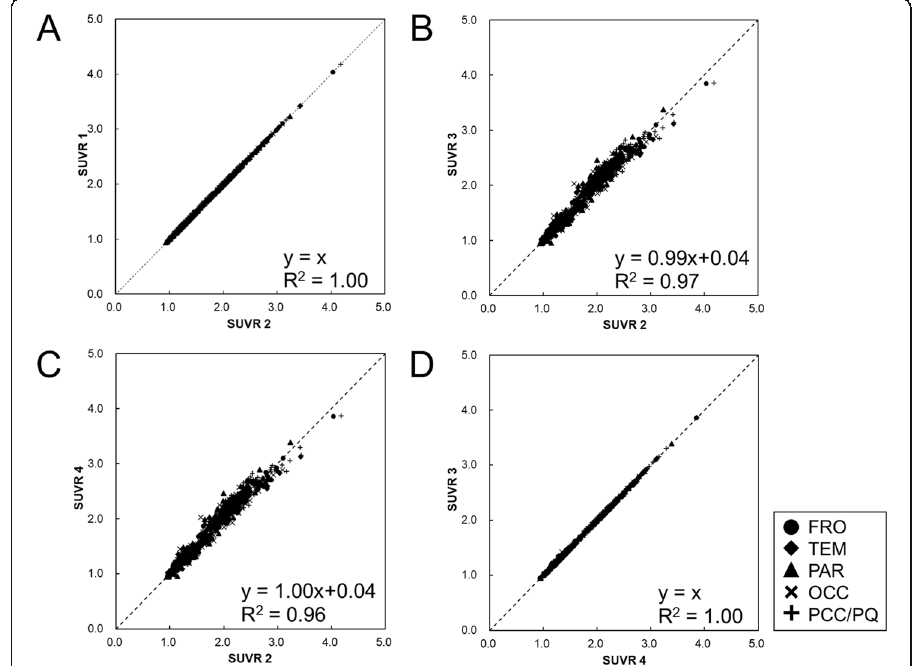
Fig. 5 Regression analysis for comparing SUVRs. Comparison between SUVR 1 and SUVR 2 ( a ), SUVR 2 and SUVR 3 ( b ), SUVR 2 and SUVR 4 ( c ), and SUVR 3 and SUVR 4 ( d ). FRO frontal lobe, TEM temporal lobe, PAR